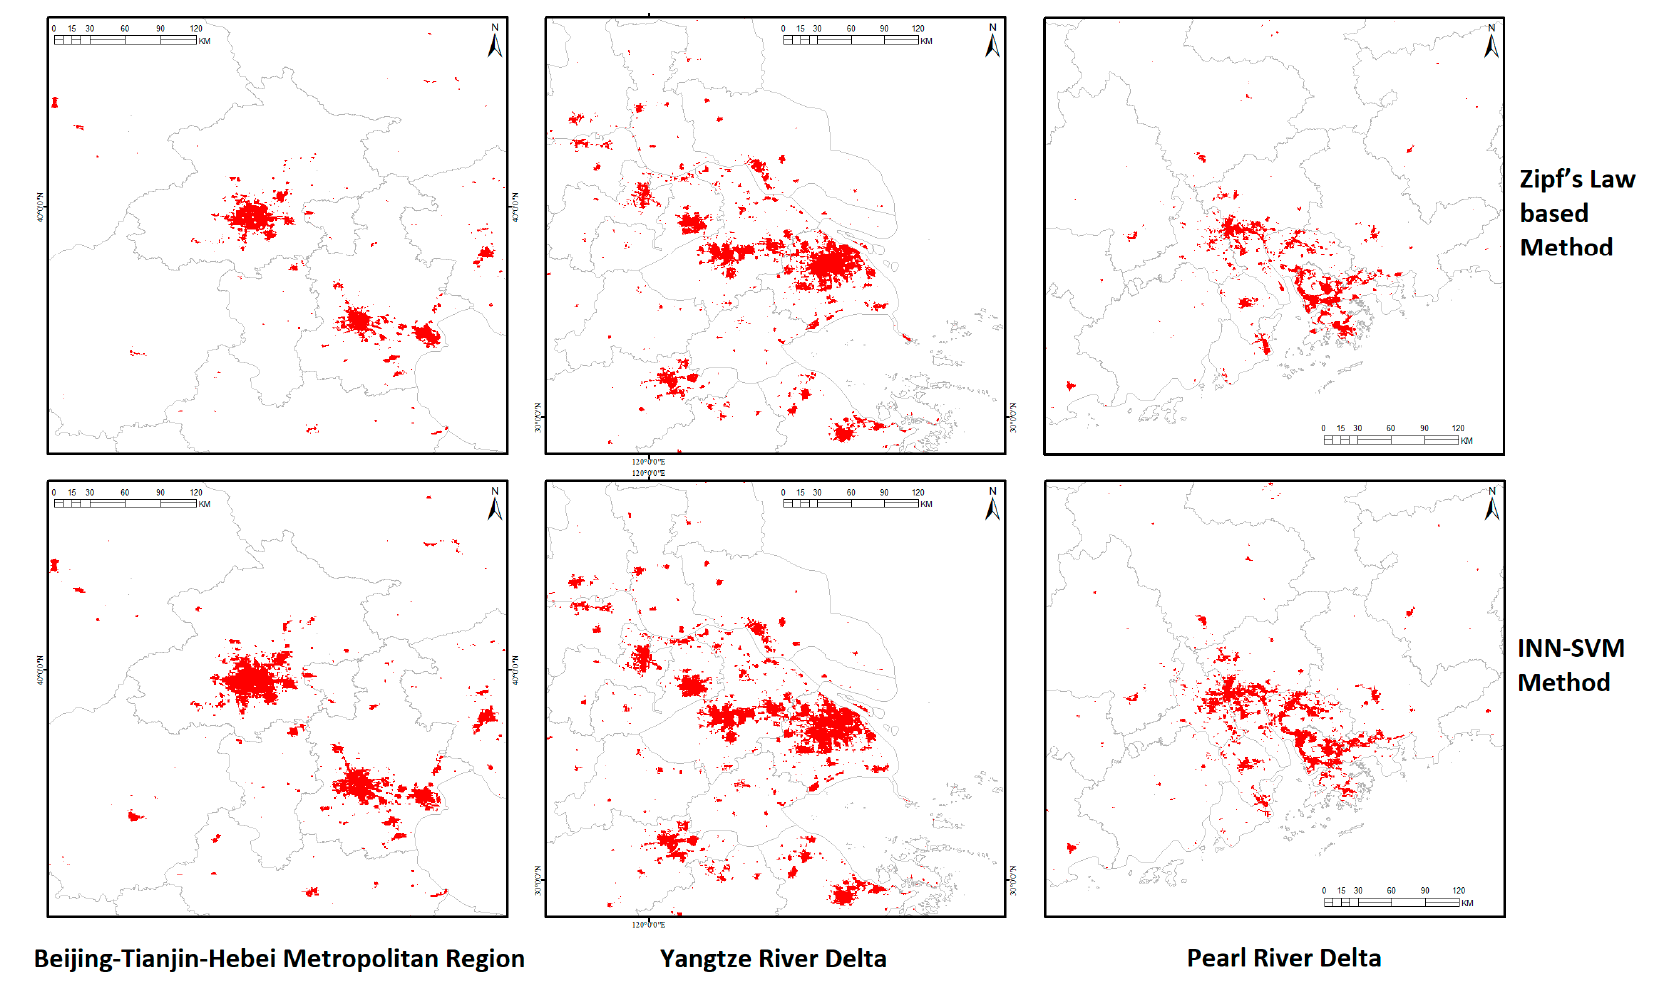
Figure 10. The urban areas extracted using the INN-SVM method [30] and those derived by the Zipf’s Law-based method.